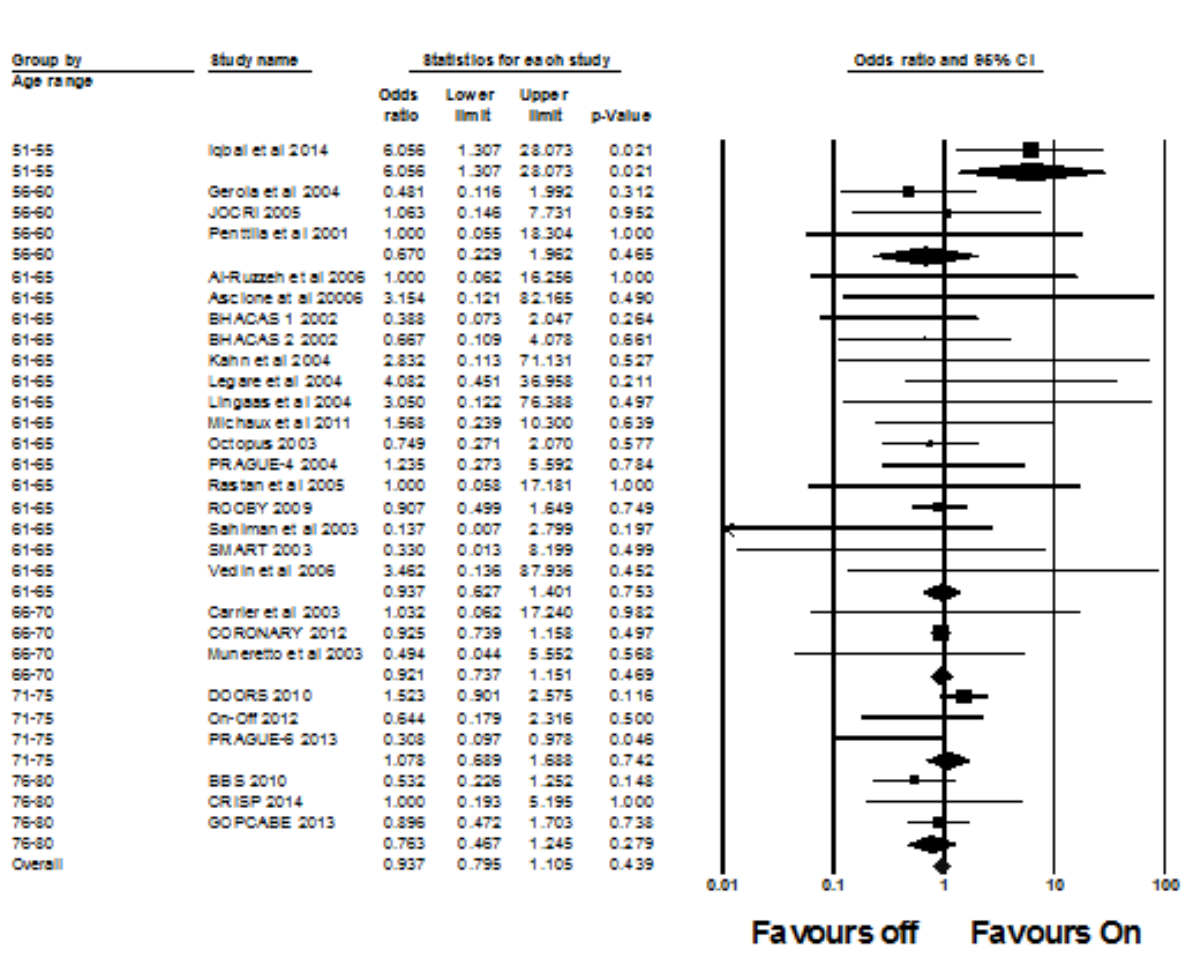
Fig. 4 – Forest plot for the incidence of myocardial infarction (MI). CI=confidence